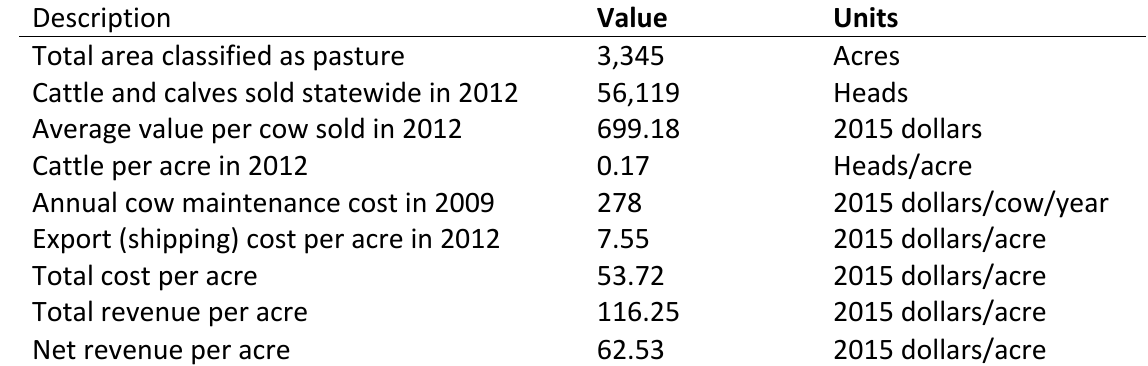
Table A1.3. Parameter descriptions and values for pasture/cattle ranching scenario Description